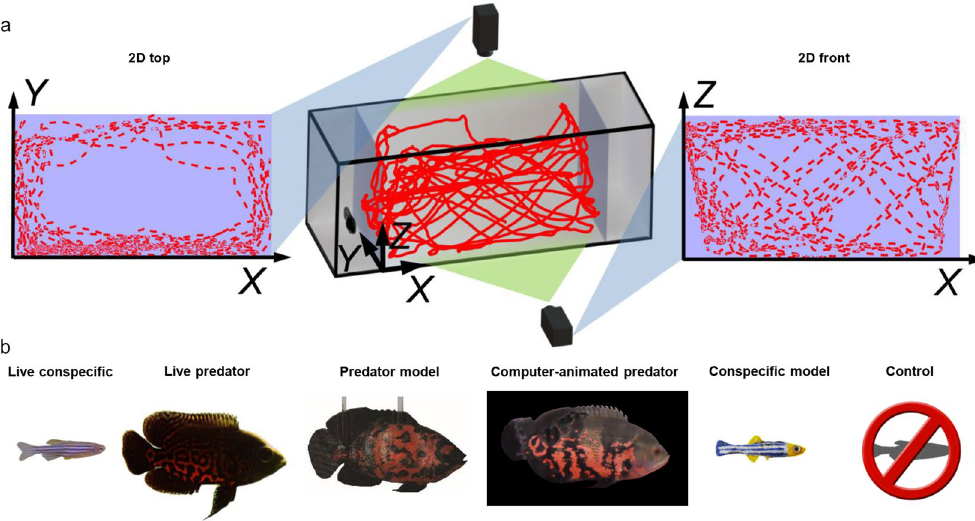
Figure 1. Schematics of the setup to acquire 2D and 3D trajectories in response to the experimental stimuli. ( a ) Representative image of the 3D reconstructed trajectory obtained through the synchronization of 2D data from top (left) and front (right) views. ( b ) Images of the stimuli utilized in the six experimental conditions comparing individual preference for an empty compartment with preference for a compartment containing one of the following stimuli: live conspecific (LC); live predator (LP), red tiger oscar fish; predator model (PM), 3D-printed model of red tiger oscar fish anchored in the stimulus compartment and beating its tail through an external motor; computer-animated predator (CAP), animated image of red tiger oscar fish projected on a computer screen; conspecific model (CM), 3D-printed model of zebrafish actuated by a robotic platform to move along realistic 3D trajectories and oscillate its body; empty compartment, control